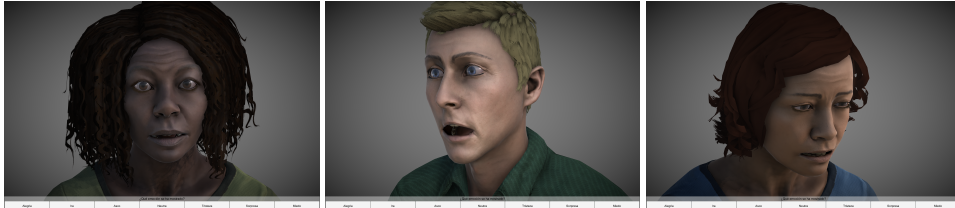
Figure 2. Some DVF